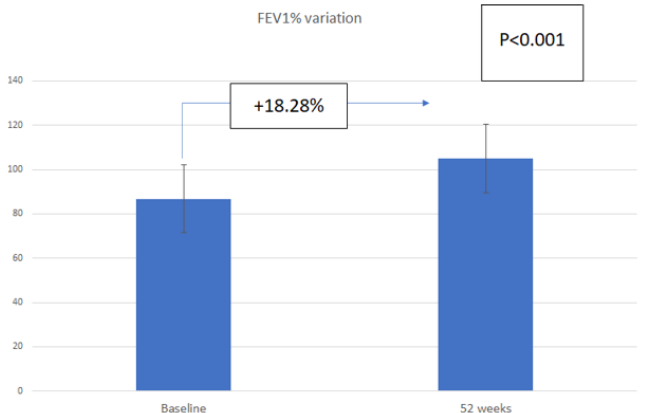
Figure 1. Change in forced expiratory volume in 1 s (FEV1%) in children and adolescents with asthma (n = 12) after 52 weeks of treatment with Omalizumab.